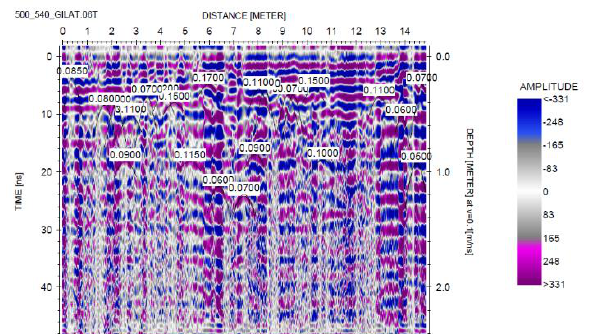
Figure 11. Analysis of diffraction electromagnetic velocities after processing in a GPR section from Bnei-Dror research site. Horizontal scale describes the location of the measurement and vertical scale describes the time/depth for the reflections. Amplitude scale is given on the right.